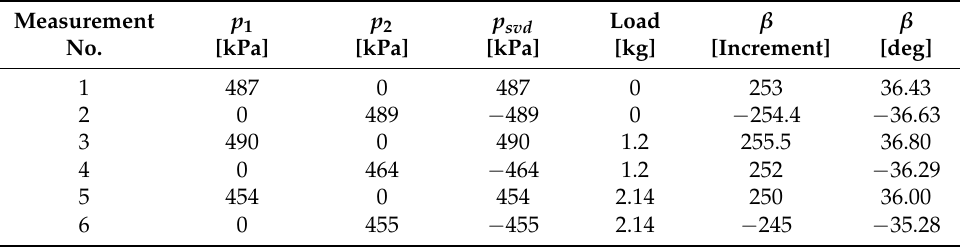
Table 1. Values of pressures in MAS 20–250 and actuator rotation at large step changes of the input